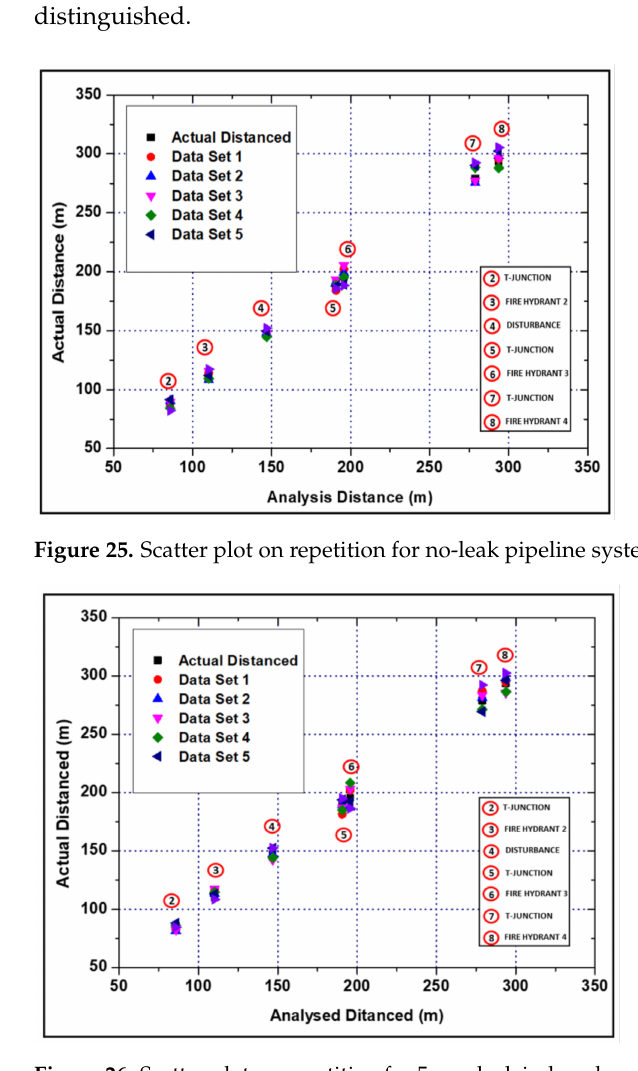
Figure 26. Scatter plot on repetition for 5 mm leak induced on fire hydrant 1 pipeline system